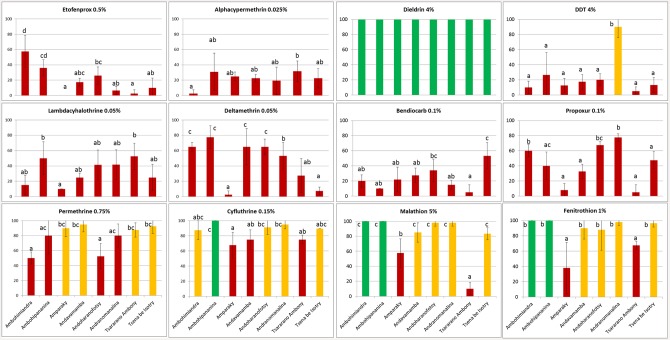
Mean of mortality rate (24 hours) per insecticide for each population.X-axis indicates populations and Y-axis indicates mortality rate in percent. Error bars represents standard errors. Diagrams color codes: in red are resistant populations, in yellow, tolerant and in green, susceptible according to WHO. Letters code (a, b, and c) above and on the side of each bar plot indicate significant difference between the mortality for each population according to the Tukey’s b test.